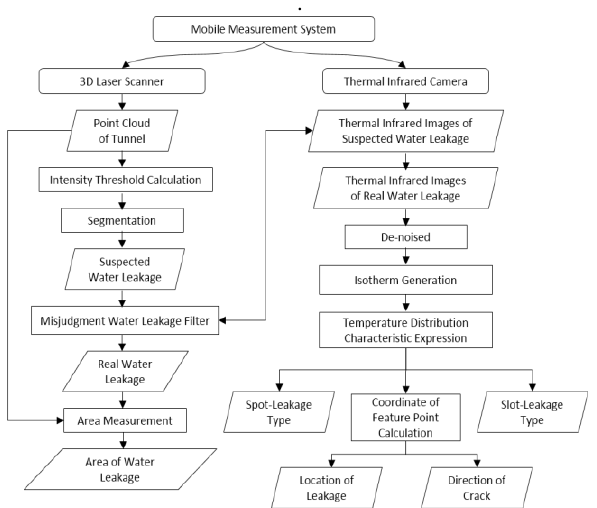
Figure 1. Flowchart of water leakage diagnosis